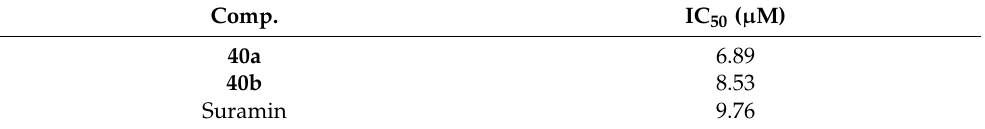
Table 44. Antidiabetic potential of the compounds (ad32 – ad33) based on PTP1B inhibitory studies. Comp.